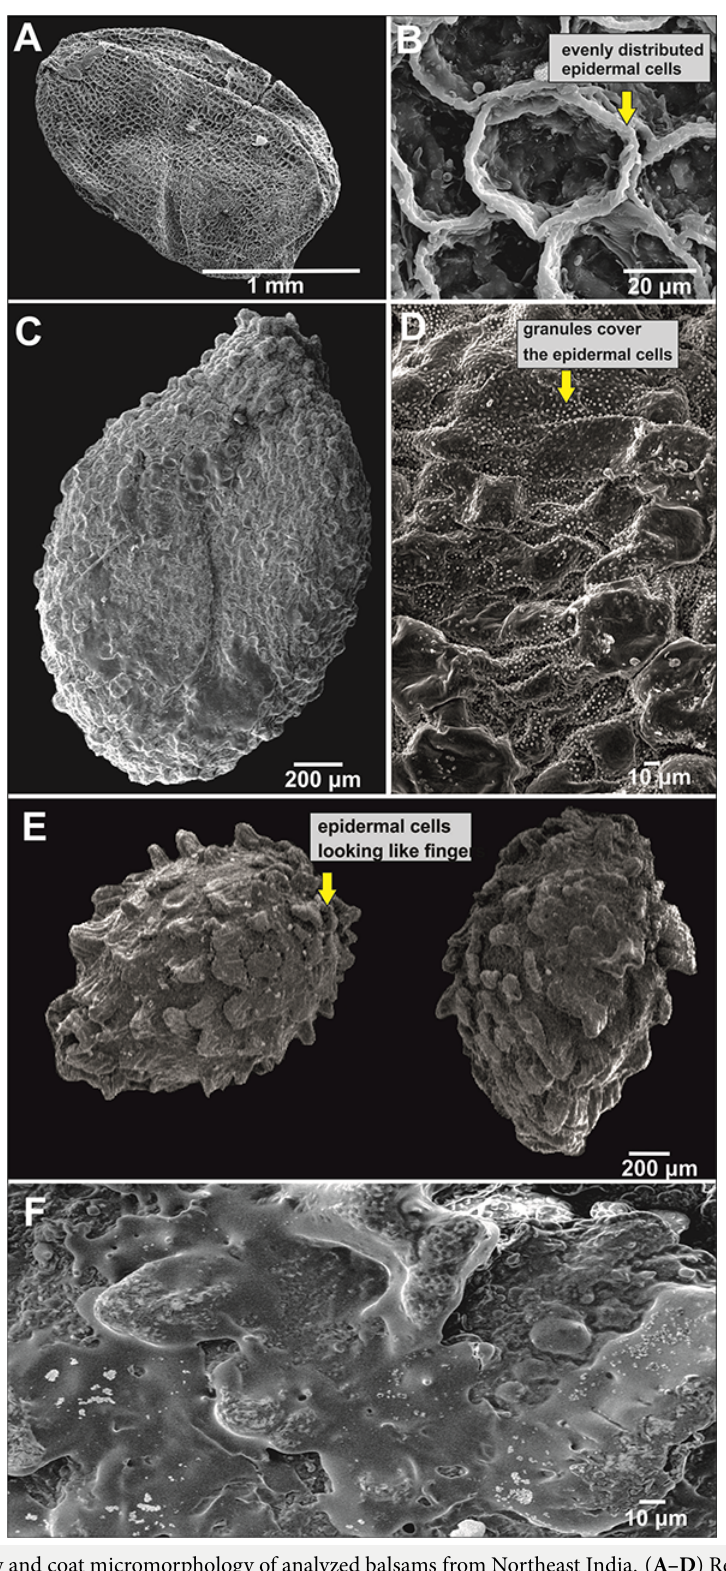
Fig ure 1 Seed general view and coat micromorphology of analyzed balsams from Northeast India. ( A–D ) Reticulate type: Impatiens anjawensis ( A,B ), I. decipiens ( C,D ); ( E,F ) protrusive type: I. drepanophora .